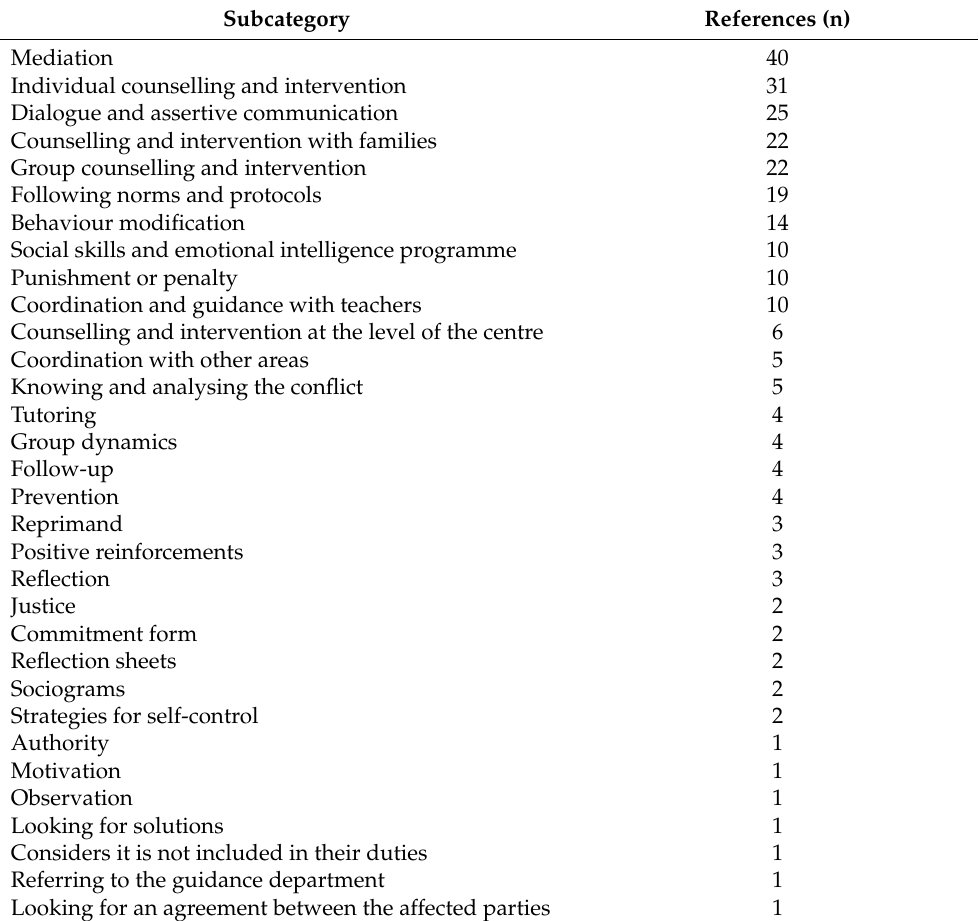
Table 6. Analysis of category 1. Intervention measures to deal with